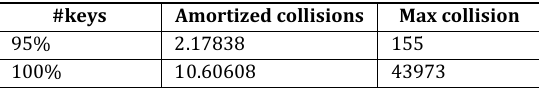
Table 2: size=49157, Murmur, Linear probling, str Len=13